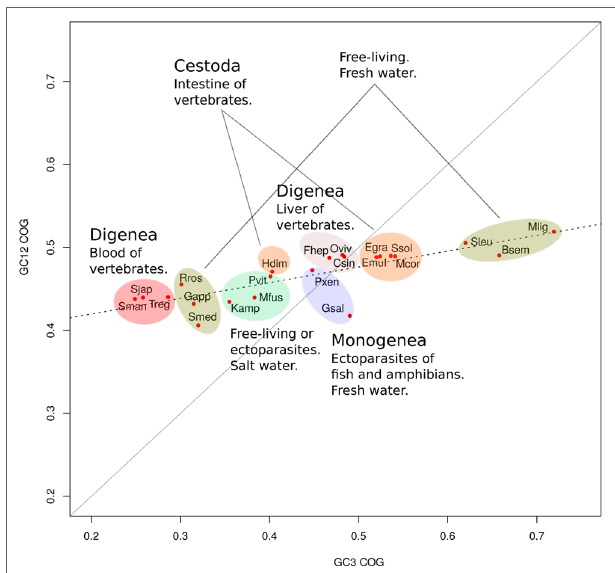
FIGURE 2 | GC variation and lifestyles correlations. Mean of GC12 versus GC3 for orthologue groups. GC3 is a better discriminator of species than GC12. GC content was linked to the ecological niche of the adult form.